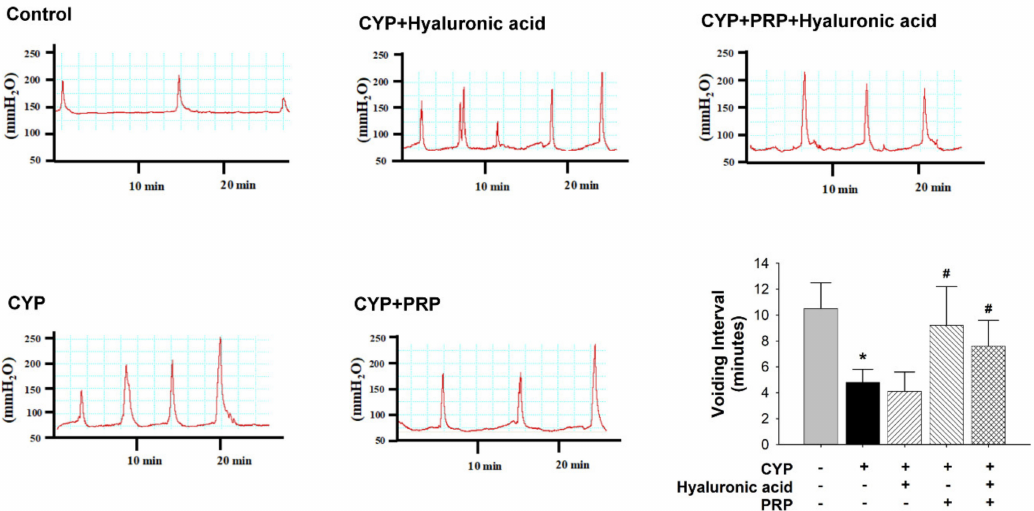
Figure 3. Cystometry traces between saline-injected control, cyclophosphamide (CYP) plus intravesical instillation with normal saline, CYP plus intravesical instillation with hyaluronic acid (1 mg / mL), CYP plus intravesical instillation with PRP, and CYP plus intravesical instillation with hyaluronic acid (1 mg / mL) plus PRP groups. The peaks in the cystometry indicate the detrusor contraction (overactivity was shown in each group). Voiding interval values are revealed in the di ff erent groups. Each bar represents the mean ± SD of six individual rats. * p < 0.05 compared to the control group. # p < 0.05 contrasted to the CYP